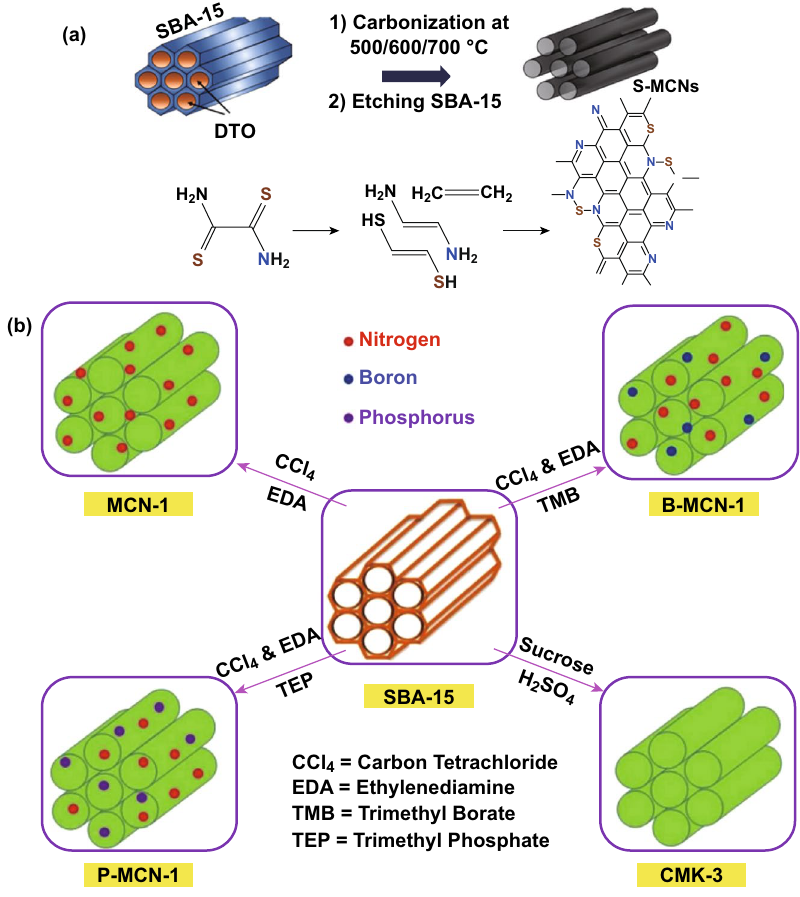
Fig. 13 a Schematic of the synthesis procedure of S-MCN [31]. b Schematic of the template synthesis method for heteroatom-doped mesoporous carbon nitrides. Reproduced with permission from Ref. [105]. Copyright permission from American Chemical Society. (Color fig- ure